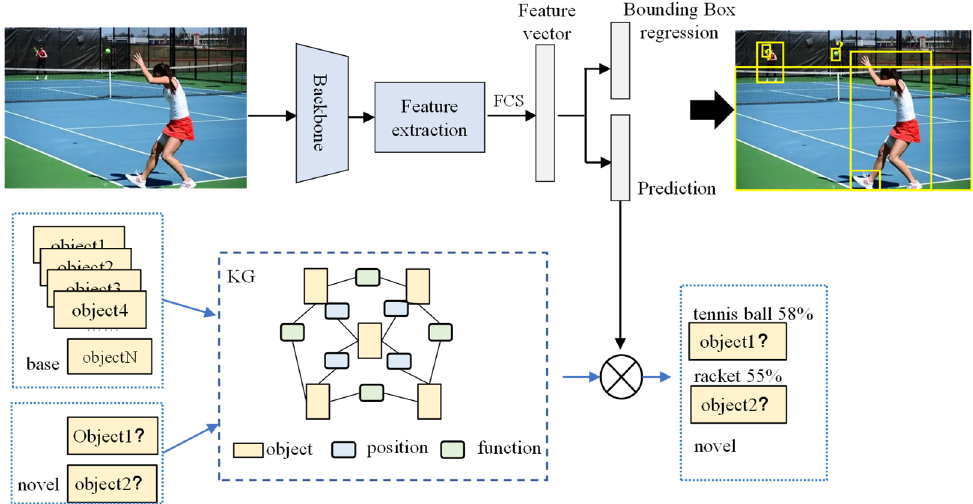
Figure 1. Few-shot object detection framework based on knowledge reasoning. A knowledge subgraph is extracted from the knowledge graph of the real world according to the objects recognized by a CNN recognition model and is applied to infer the unknown objects. ⊗ : dot product.